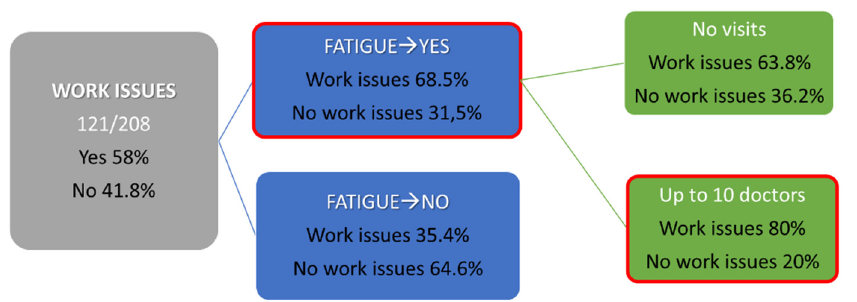
Figure 5. Decision tree reveals that fatigue appears to be muchhigher in patients with work prob-